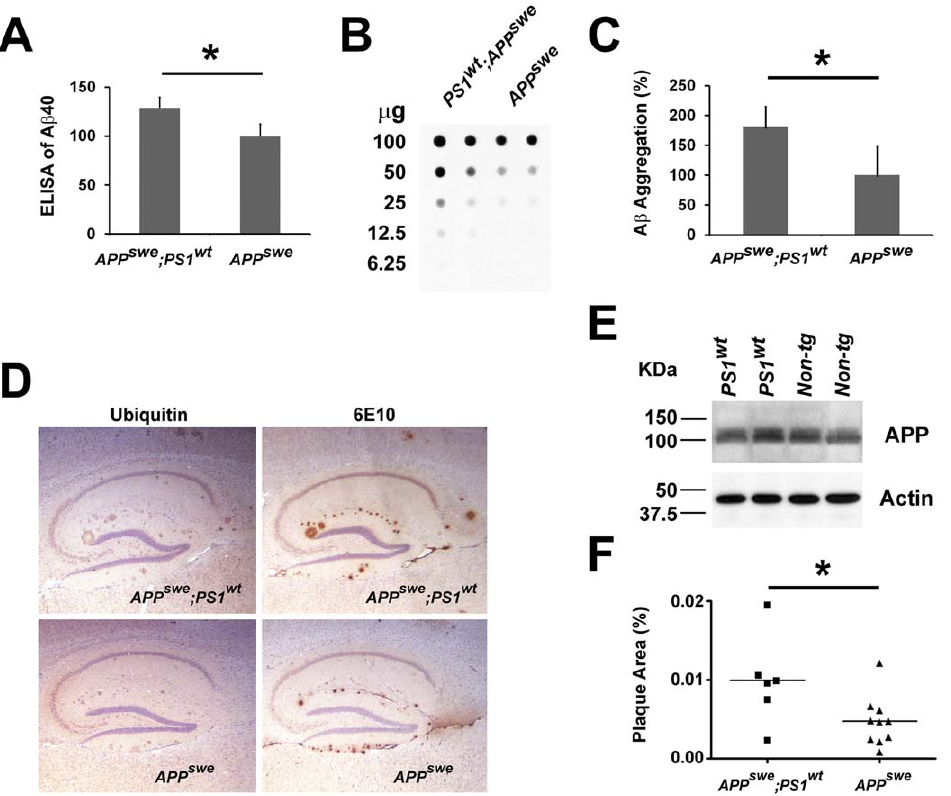
Figure 3. Increase in generation and deposition A b in the brains of APP swe ;PS1 mice. (A) ELISA analysis of A b 40 peptides in the protein extracts of brains of PS1 and non-transgenic control mice. The data were average + / 2 SEM from 5 mice for each genotype. (B) Sagittal brain sections (10 m m) of hippocampus area of 22-months old APP swe ;PS1 and APP swe female mice. The A b plaques were visualized by immunostaining with antibodies specific to ubiquitin and A b peptides (6E10). (C) Quantitative analysis of the levels of A b aggregation in the brains of APP swe ;PS1 and APP swe mice at 22 months of age by filter trap assay. (D) Quantification of the signals of A b aggregations in the filter trap assay using Image J program. (E) Analysis of A b deposition using unbiased stereology in the hippocampus of 22-months old APP swe ;PS1 (n=6) and APP swe (n=10) female mice.